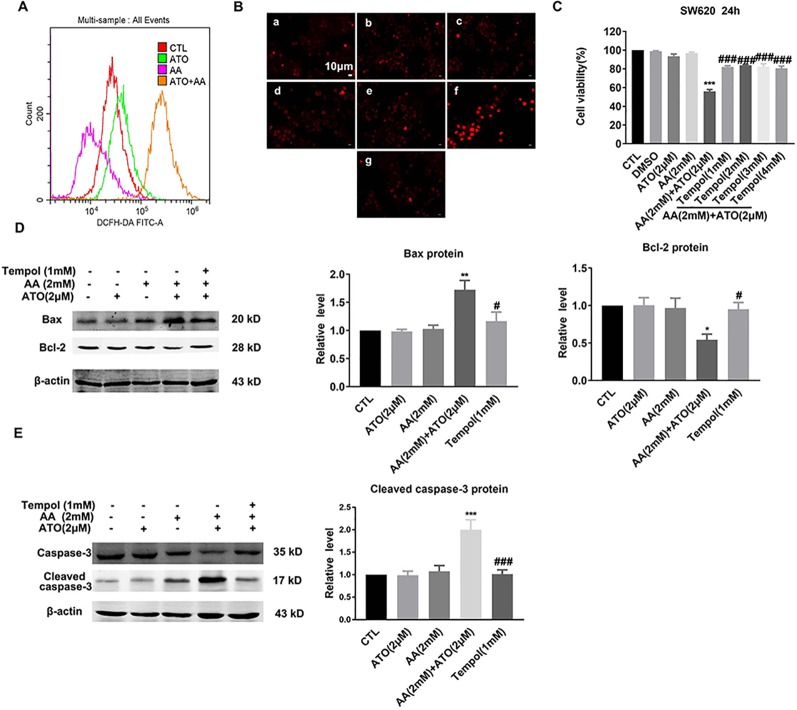
Antagonistic effects of tempol on the pro-apoptotic action of ATO (2 μM)/AA (2 mM) combination in SW620 cells. (A) Effects of ATO, AA, and ATO/AA combination on the levels of intracellular reactive oxygen species (ROS) as measured by flow cytometry using an oxidation-sensitive fluorescent probe, 2′,7′-dichlorodihydrofluorescein diacetate (DCFH-DA). Note that ATO/AA combination caused the greatest ROS production as indicated by the highest cell count of DCFH-DA staining. (B) Inhibitory effect of an ROS scavenger tempol (1 mM) on the synergistic enhancement of ROS production induced by ATO (2 μM)/AA (2 mM) combination treatment of SW620 cells, as determined by a ROS fluorescent probe. (a) Control, (b) ATO (2 μM); (c) AA (1 mM); (d) AA (1 mM) + ATO (2 μM); (e) AA (2 mM); (f) AA (2 mM) + ATO (2 μM); (g) AA (2 mM) + ATO (2 μM) + tempol (1 mM). Magnification: ×200. Scale bar: 10 μm. (C) Inhibitory effect of tempol (1 mM) on the synergistic suppression of cell viability induced by ATO (2 μM)/AA (2 mM) combination treatment of SW620 cells. SW620 cells were pretreated with tempol for 1 h before incubating with ATO (2 μM) + AA (2 mM) for 24 h. The data are represented as mean ± SEM (n = 3). ***P < 0.001 vs. Ctl. ###
P < 0.001 vs. AA + ATO. (D) Alleviating effects of tempol on the upregulation of Bax protein and downregulation of Bcl-2 protein induced by ATO (2 μM)/AA (2 mM) combination treatment of SW620 cells. (E) Reversing effect of tempol on upregulation of cleaved-caspase-3 levels induced by ATO (2 μM)/AA (2 mM) combination treatment. Beta-actin was used as an internal control. **P < 0.01, vs. Ctl. #
P < 0.05 vs. AA and ATO. ##
P < 0.01 vs. AA +ATO; n = 5.